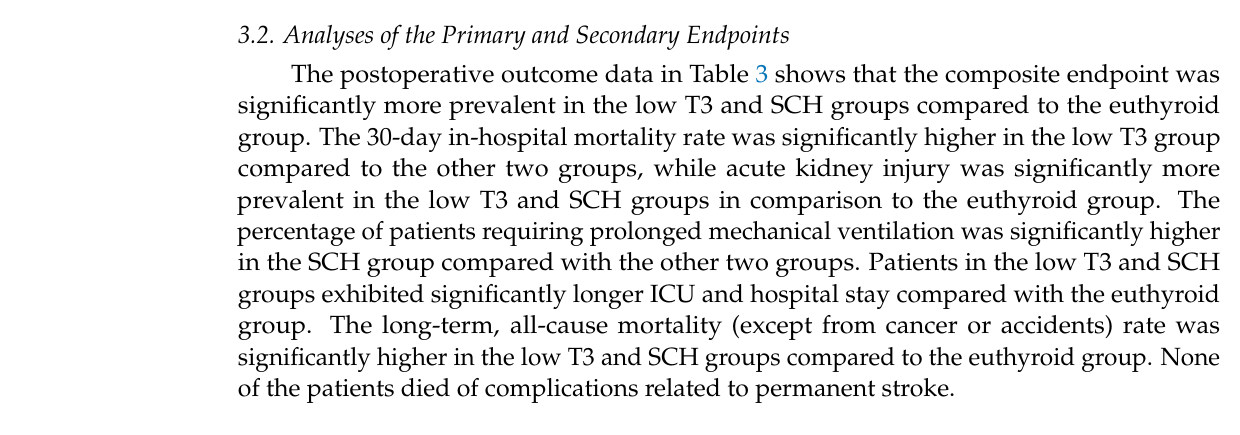
Table 3. Postoperative data including primary and secondary outcomes among the three groups, designated by thyroid function